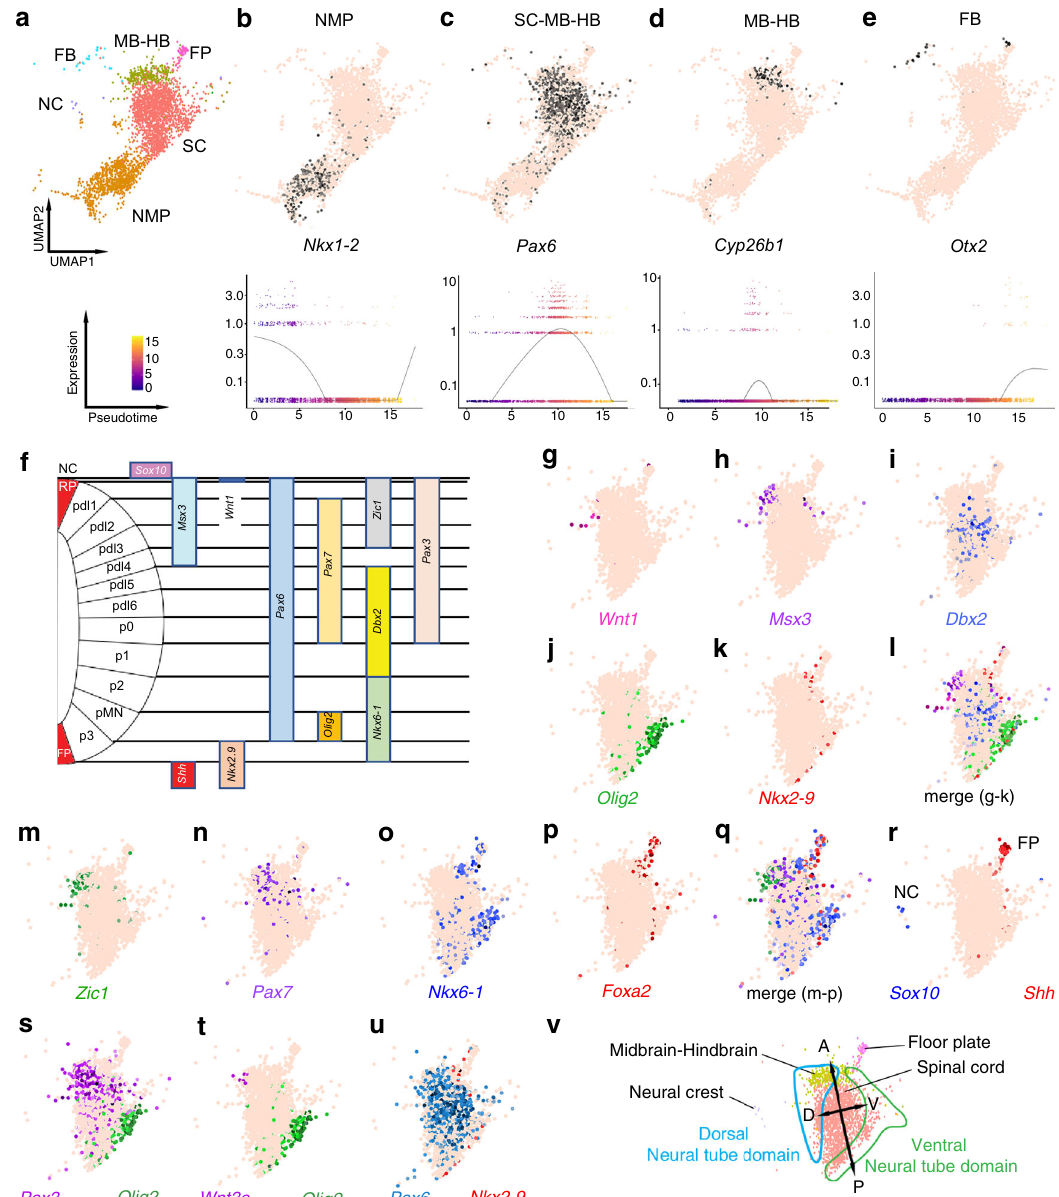
Fig. 10 Neurectoderm clusters and neural pseudotime differentiation of their speci fi c marker genes and segregation of cell states along the dorsoventral axis of the neural tube. a Selected ectoderm clusters: FB: forebrain, MB-HB: midbrain – hindbrain, FP: fl oor plate, SC: spinal cord, NMP: neuromesodermal progenitors, NC: neural crest. b – e (top) UMAP plot and (bottom) spline plot representing changes of expression over pseudotime for marker genes of each cluster: b Nkx1-2 for NMP, c Pax6 for SC, MB-HB, d Cyp26b1 for HB, e Otx2 for FB. f Schematic of the expression pattern of genes expressed in domains of the mouse embryo neural tube along its DV axis. Left: one half of the neural tube in cross-section. From dorsal to ventral: NC: neural crest (outside of the neural tube), RP: roof plate, then arrayed along the DV axis of the neural tube are various progenitor domains: pdl1 – pdl6, p0 – p2, pMN (motor neuron), p3 then ventrally FP: fl oor plate. Domains of expression of the markers used to analyse the segregation of cells of neural clusters along AP axis are indicated as bars on the right. g – k Coloured cells expressing speci fi c markers of the dorsal neural tube domain: Wnt1 , Msx3 ; intermediate domain: Dbx2 ; ventral domain: Olig2 , Nkx2-9 . l Merge of all cells expressing these fi ve marker genes. m – p Coloured cells expressing speci fi c markers of dorsal domain: Zic1 , Pax7 , ventral domain: Nkx6-1 , Foxa2 , q merge of coloured cells expressing these four marker genes. r Position of NC and FP clusters expressing, respectively, Sox10 and Shh . s – u Merge of coloured cells for one dorsal and one ventral markers: s Pax3 (dorsal) and Olig2 (ventral ) , t Wnt3a (dorsal) and Olig2 (ventral), u Pax6 (dorsal) and Nkx2-9 (ventral). v Summary of clustering of cells expressing dorsal and ventral speci fi c markers, clearly showing the segregation of cell states along the DV axis of the neural tube in a manner similar to what is observed in the mouse